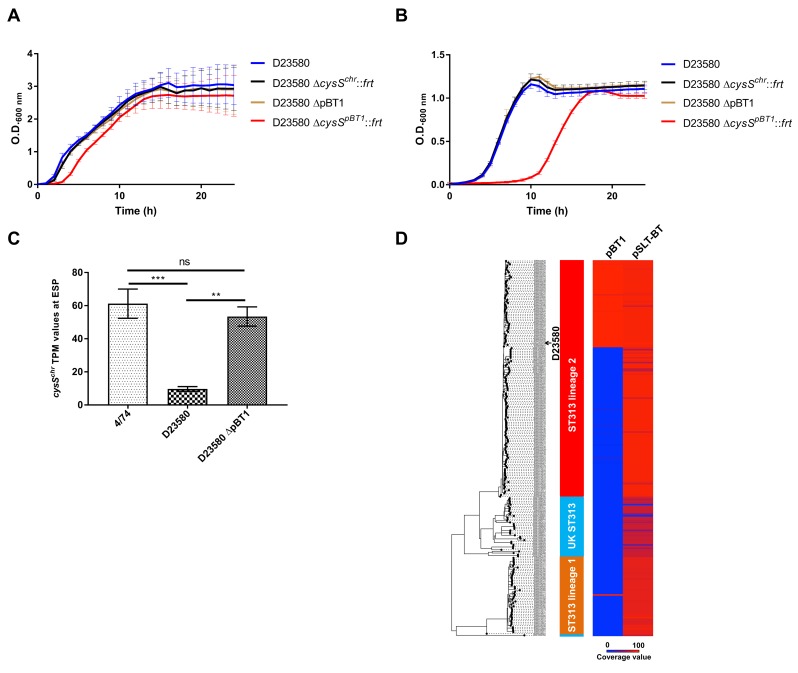
The pBT1-encoded cysS is required for optimal growth of S. Typhimurium D23580.(A) Growth curves of D23580 WT, D23580 ΔcysSchr::frt, D23580 pBT1-cured strain, and D23580 ΔcysSpBT1::frt strains in LB medium, n = 8 (standard deviations are represented) (S1 Data). (B) Growth curves in minimal M9 medium supplemented with 0.4% glucose, n = 5 (standard deviations are represented) (S1 Data). (C) Comparison of cysSchr expression levels (TPM values) of 4/74 (n = 3), D23580 (n = 3), and the D23580 pBT1-cured strain (n = 2) in the ESP growth condition (S1 Data). Bars represent mean values and standard deviations. Significant differences (***) indicate p-value <0.001. (D) The pBT1 plasmid is present in a subset of ST313 isolates of lineage 2 and in one isolate from lineage 1. Isolate names, ST313 lineage, and coverage value for pBT1 and pSLT-BT are included in S8 Table. ESP, early stationary phase; LB, Lennox broth; ns, not significant; OD, optical density; ST, sequence type; TPM, transcripts per million; WT, wild type.